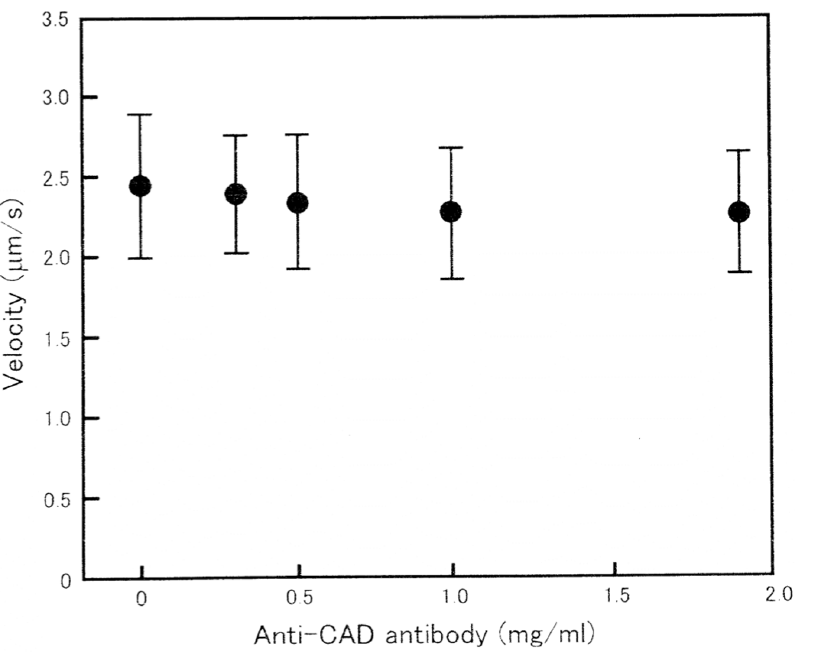
Figure 2. No appreciable effect of anti-CAD antibody on invitro actin filament sliding on myosin heads. In this and Figs. 4 and 5, mean velocities of sliding are plotted against antibody concentration with vertical bars indicating S.D., and each data point is obtained from 80–120 measurements.